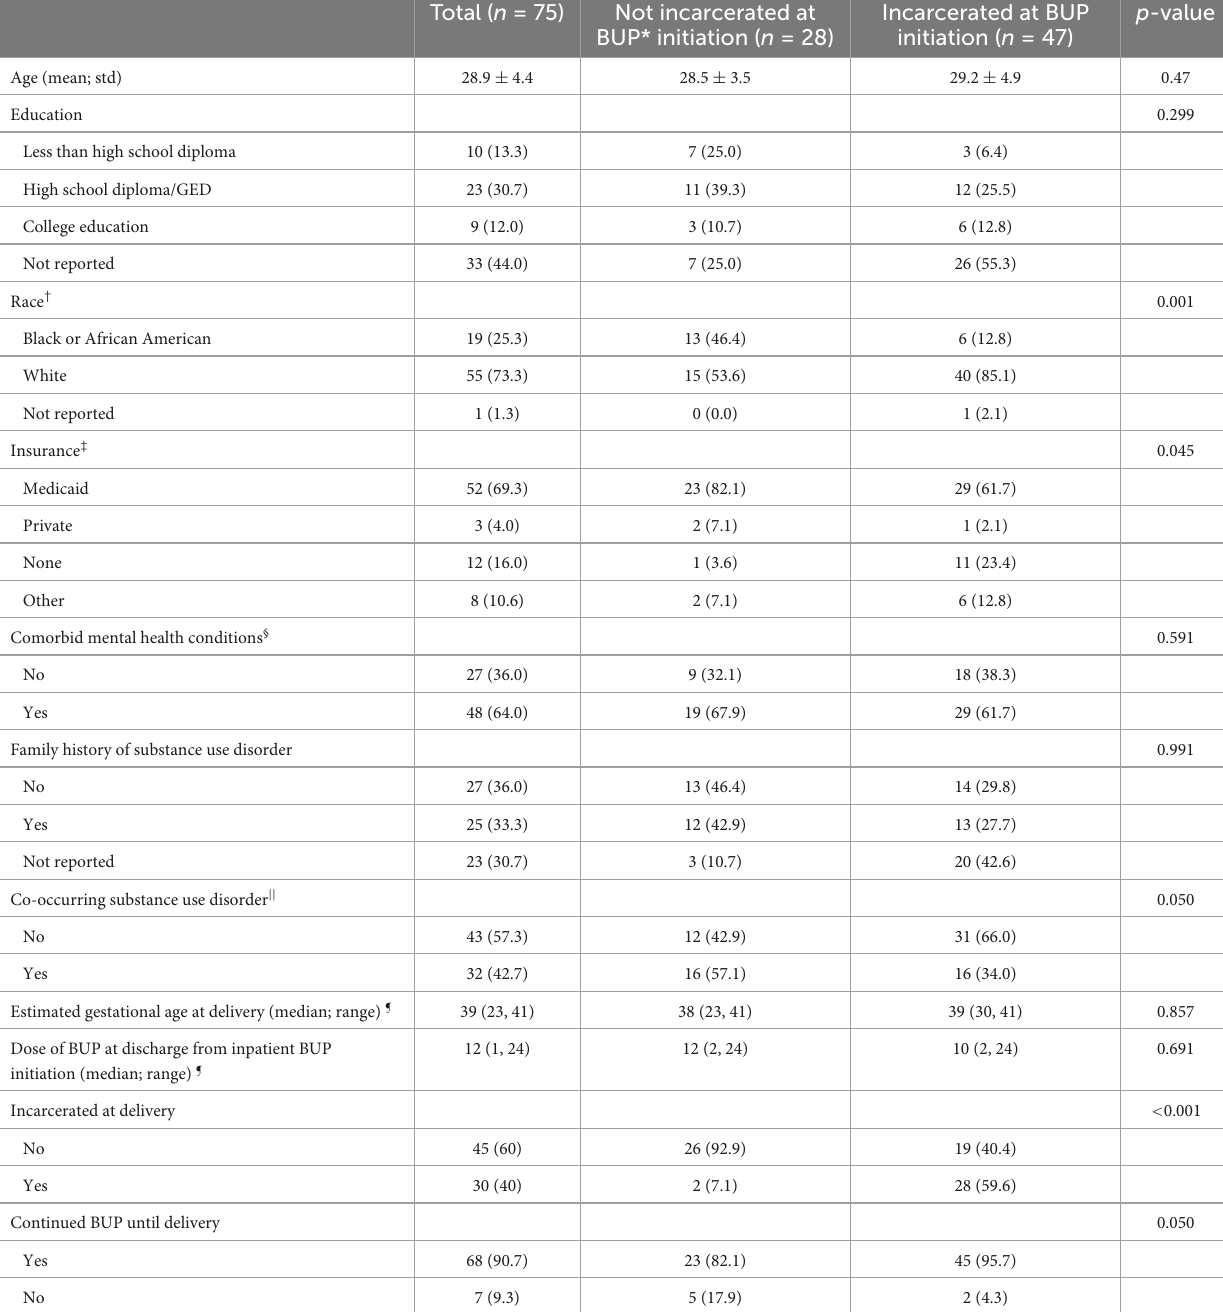
Total ( n = 75) Not incarcerated at Incarcerated at BUP p -value BUP* initiation ( n = 28) initiation ( n = 47)